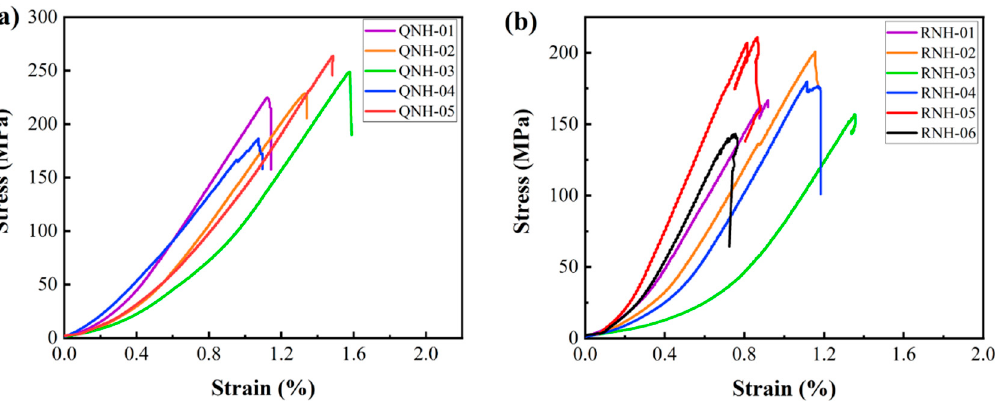
Figure 9. Stress–strain curves of a uniaxial compression test: ( a ) strongly welded tuffs; ( b ) weakly Figure 9. Stress-strain curves of a uniaxial compression test. ( a ) The strongly welded tuffs. ( b ) The welded weakly welded tuffs. Table 2. The results of the mechanical properties of different welded tuff.